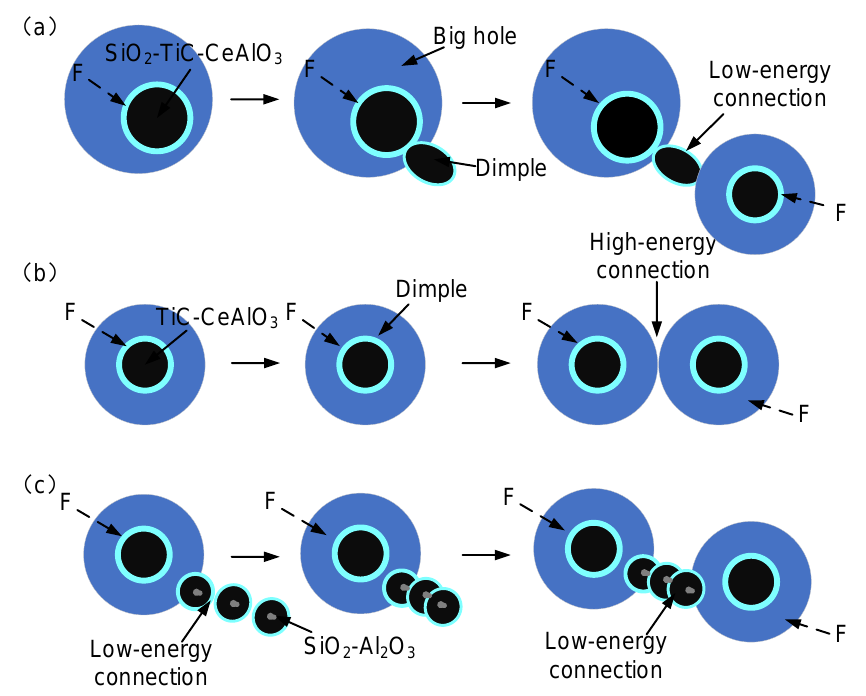
Figure 5. Schematic diagram of ductile fracture mechanism under different heat inputs: ( a ) 1.45 kJ/mm; ( b ) 1.78 kJ/mm; ( c ) 2.31 kJ/mm.